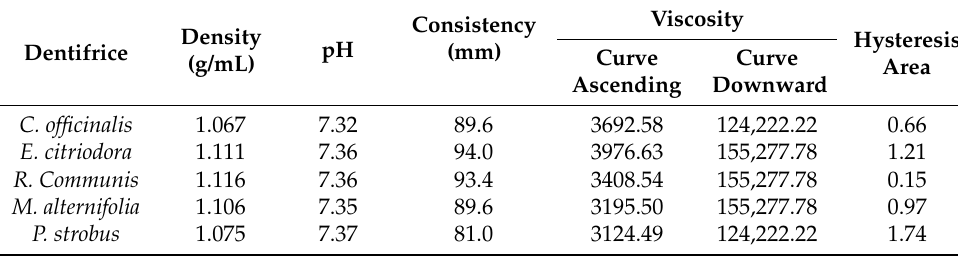
Table 1. Physical-chemical properties of experimental